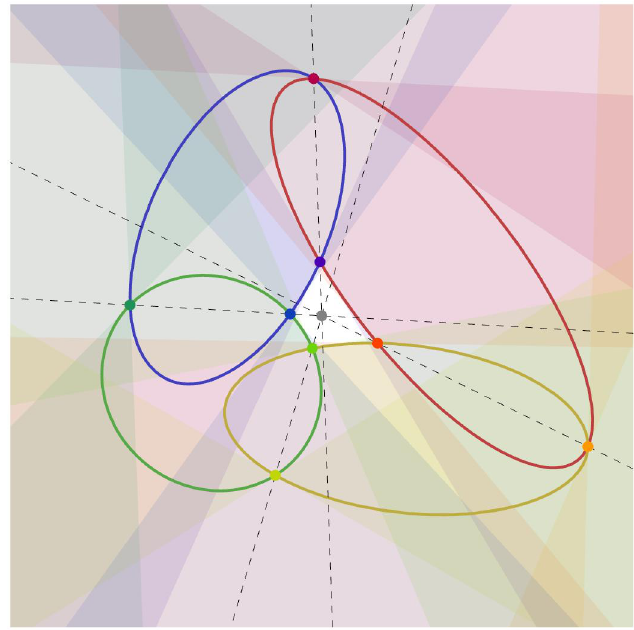
Figure 9. The threshold singularities of Box_4E . All E-surfaces belong to the same group, such that a common source has to be found. The tangents at each intersection define an X -shaped region. If the source were located within this region, the corresponding E-surface intersection would result in a miscancelling pole in the respective residues. We therefore exlcude the colorful regions. Only a source in the white region allows for the local cancellation of all poles among the E-surface residues. Curiously, the (dashed) lines connecting the two intersections of two ellipses all intersect in a single point